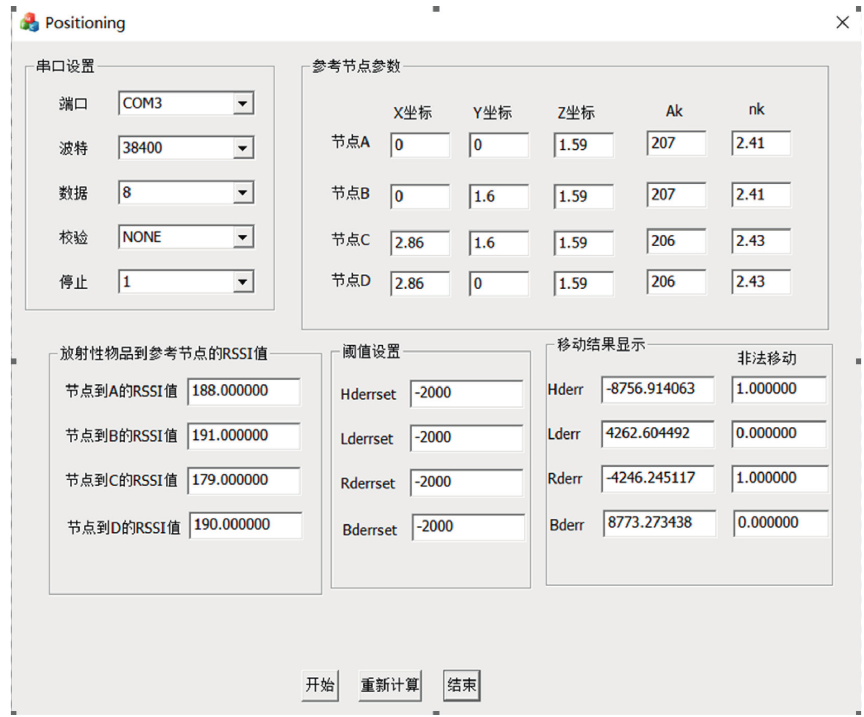
Figure 15: Illegal detection test result. Table 2: Illegal detection results based on spatial projection